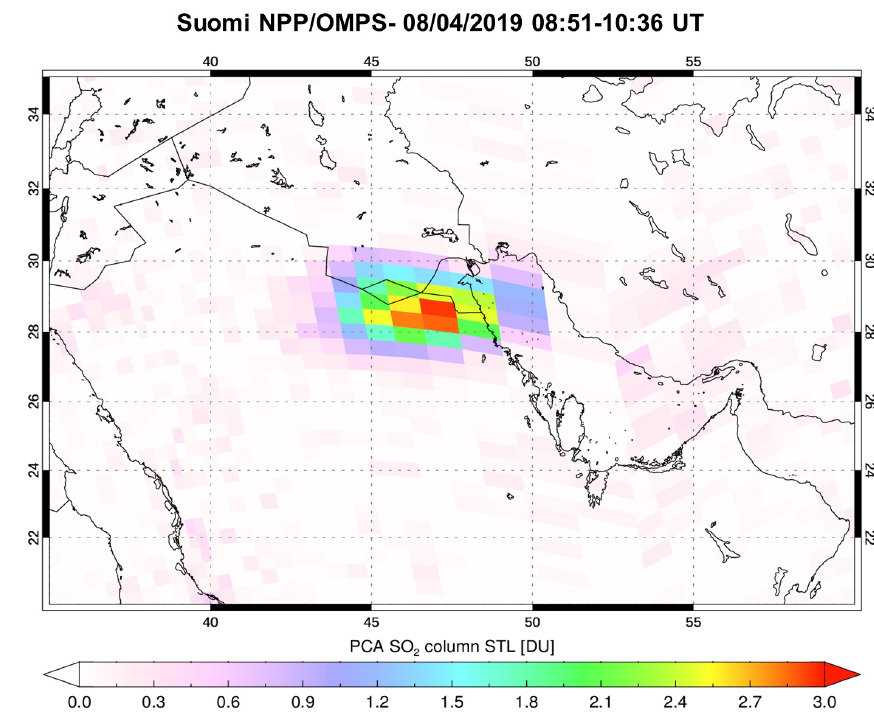
Figure 15. OMPS SO 2 STL columns plotted using a linear scale for 4 August